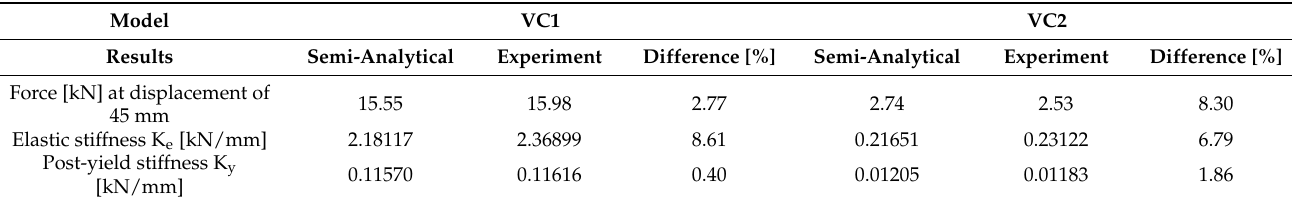
Table 2. Semi-analytical vs. experimental results for vertical components.